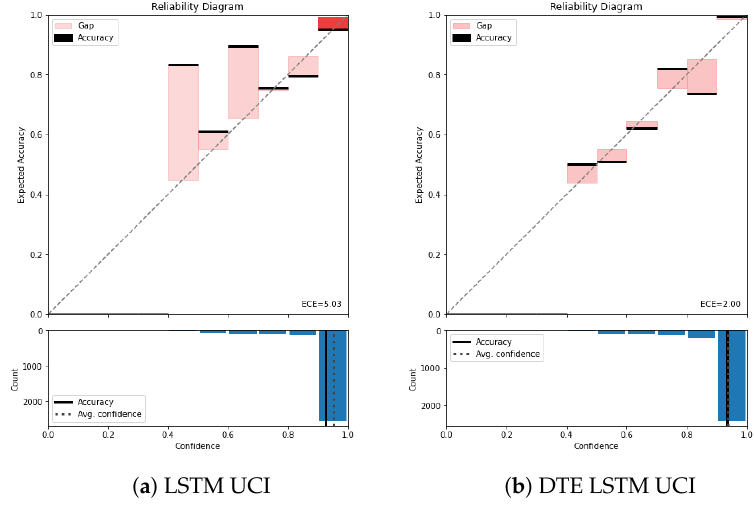
Figure A2. Reliability diagram of UCI for ( a ) LSTM and ( b ) DTE LSTM.